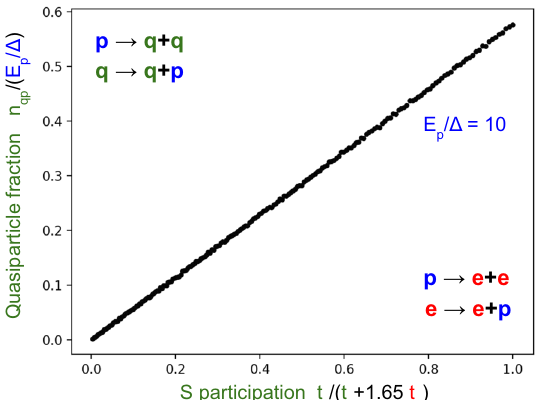
Fig. 6 Reduction of quasiparticles from channeling energy to normal metal. Plot of normalized number of quasiparticles versus participation of the superconductor, showing the reduction of quasiparticles using normal metal. The participation formula is expressed with the thickness of the superconductor t s and normal t n metal, fi tting the constant 1.65 to give a linear dependence. The initial phonon energy is E p / Δ = 10. The insets show the four scattering processes for the superconductor and the normal metal.